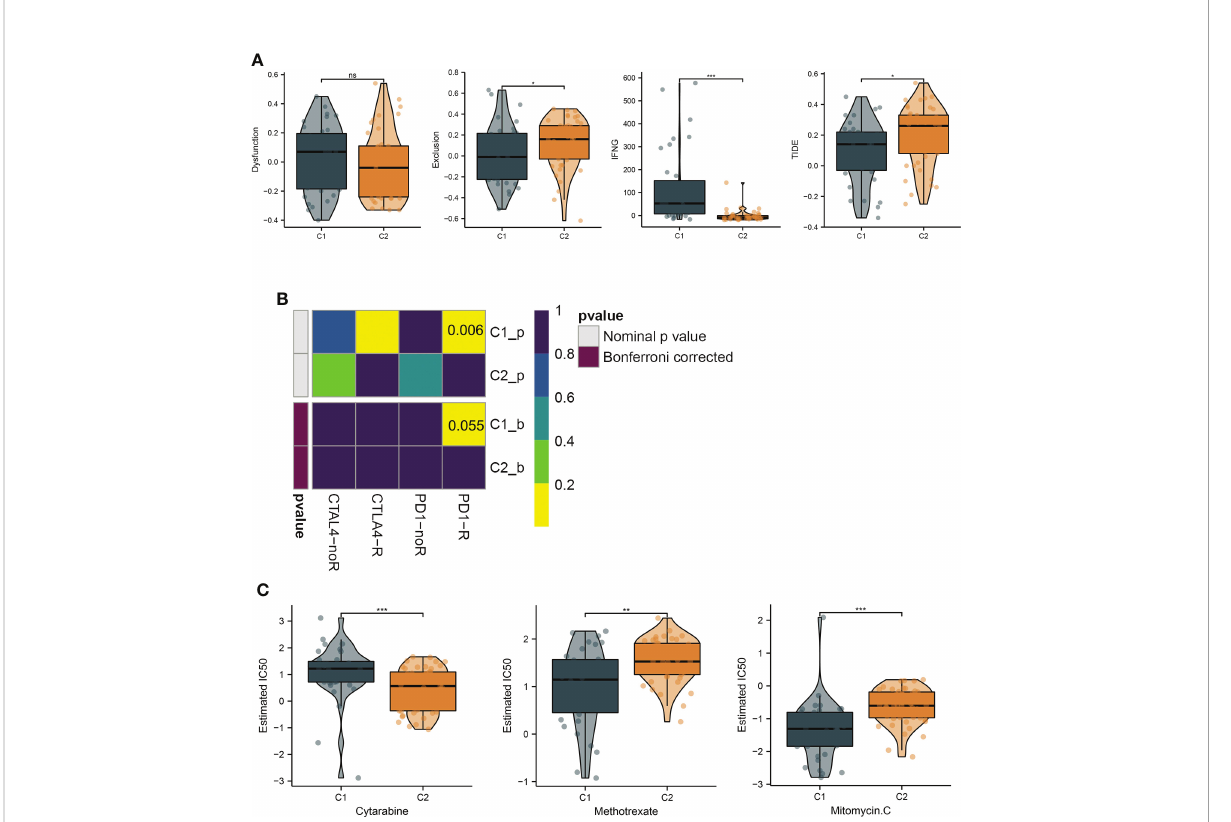
FIGURE 3 Hypoxia subtypes correlate with immunosuppression and their chemotherapeutic drugs development. (A) The TIDE estimation showing the dysfunction, exclusion, IFNG, and TIDE scores of the UM samples. (B) The submap of the expression similarity compared with immunotherapy response/nonresponse cohort. (C) Box plots present the IC50 differences of GDSC drugs between the subtypes. *, **, ***, and ns represents p-value<0.05, 0.01, 0.001, and not signi fi cant,